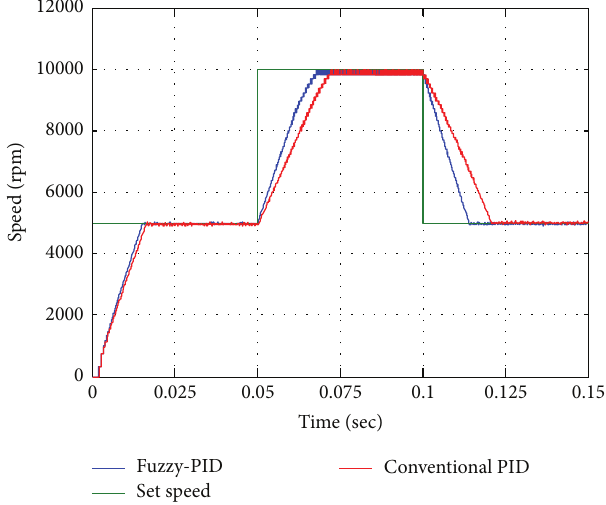
Figure 14: Step speed change (5000–10000–5000)